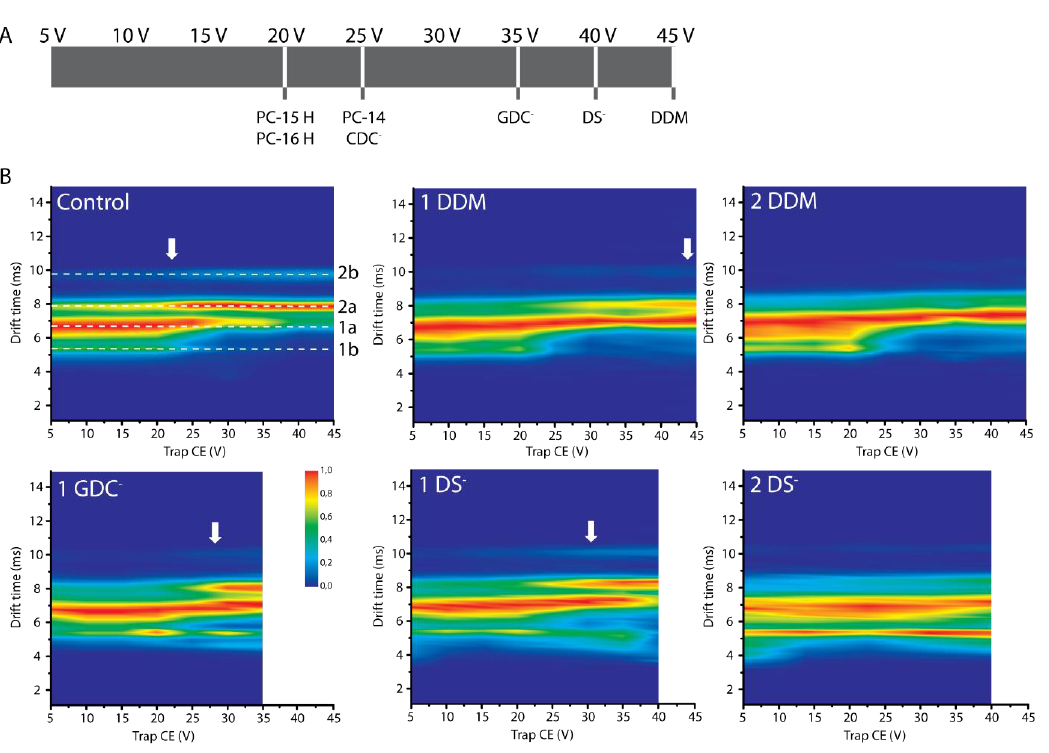
Figure 4. Conformational transitions probed by CIU. ( A ) The lines indicate at which trap CE voltage binding of different detergents to the 7+ charge state of α-syn is lost (no binding: S/N from peak with 1 detergent bound ≤3). ( B ) CIU plots of the 7+ charge state of α-syn. Top row: control without detergent present, with one DDM and with two DDM bound. Bottom row: with one GDC - bound, and one and two DS - bound. Intensities are scaled as described in the method section. Four different conformational families are labelled 1a, 1b, 2a and 2b in the control plot. Here ‘1’ indicates more compact states, ‘2’ indicates more extended conformations, ‘a’ indicates more intense states and ‘b’ indicates less intense conformations. The CIU50 value, indicating the transition between conformation 1a and 2a, is indicated by the white arrow in cases where unfolding occurs before detergent binding is lost. When detergent binding is lost below 45 V, this is indicated by blank spaces in the plots.